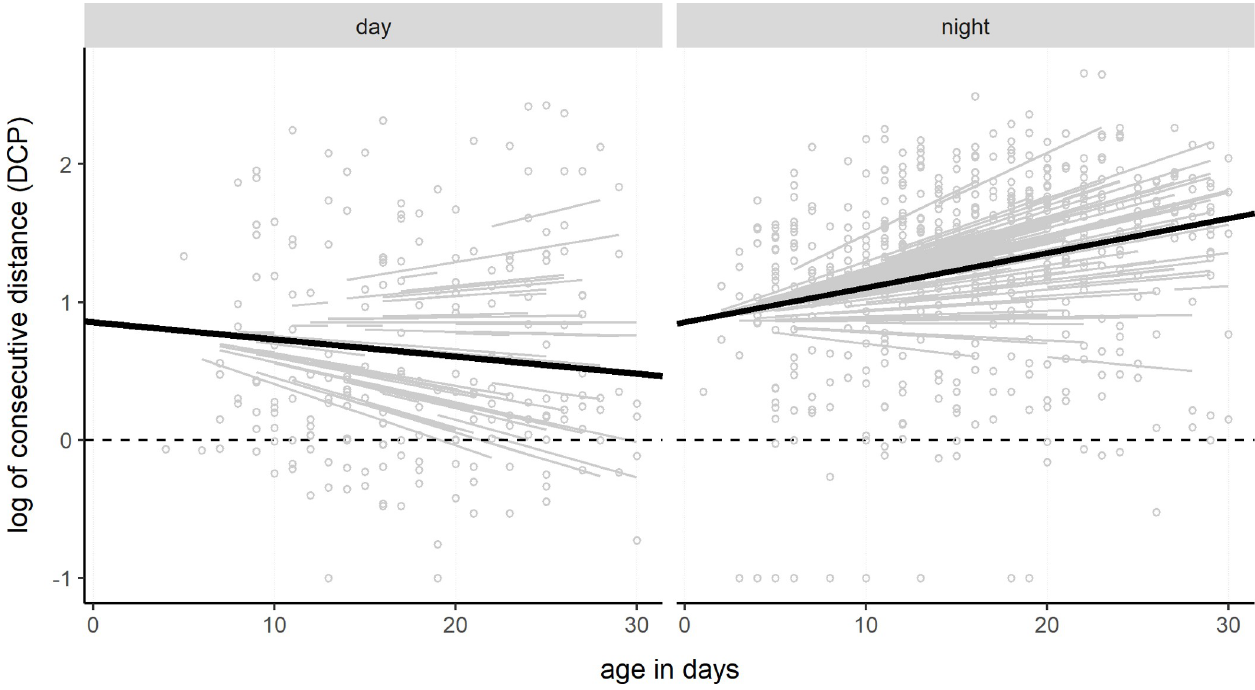
Fig 3. Distance moved by pre-weaning leverets. The log-transformed distances between consecutive day-day and day-night locations are shown depending on the leverets’ age. With increasing age, leverets moved less in the daytime and more at nighttime. https://doi.org/10.1371/journal.pone.0222205.g003 PLOS ONE | https://doi.org/10.1371/journal.pone.0222205 September 9,